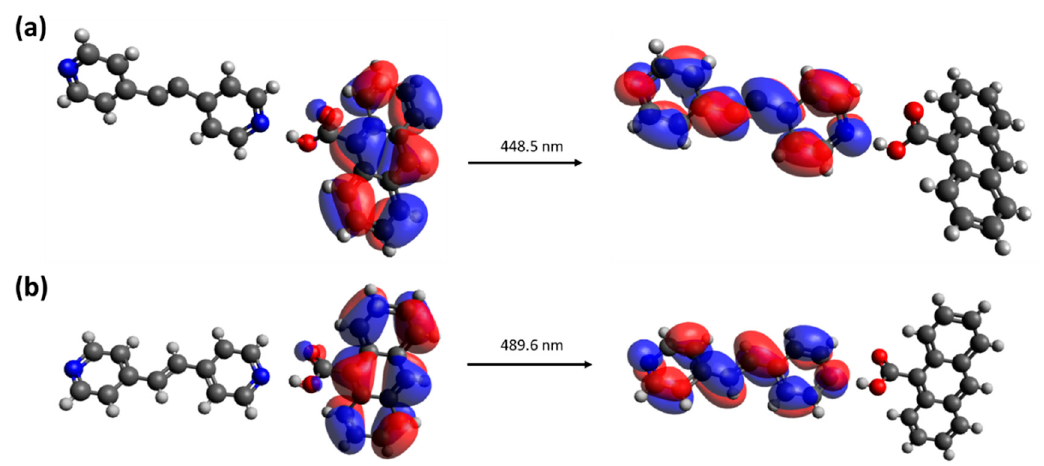
Figure 7. Molecular orbitals associated with the ( a ) ACA-BPE and ( b ) ACA-BPEE.